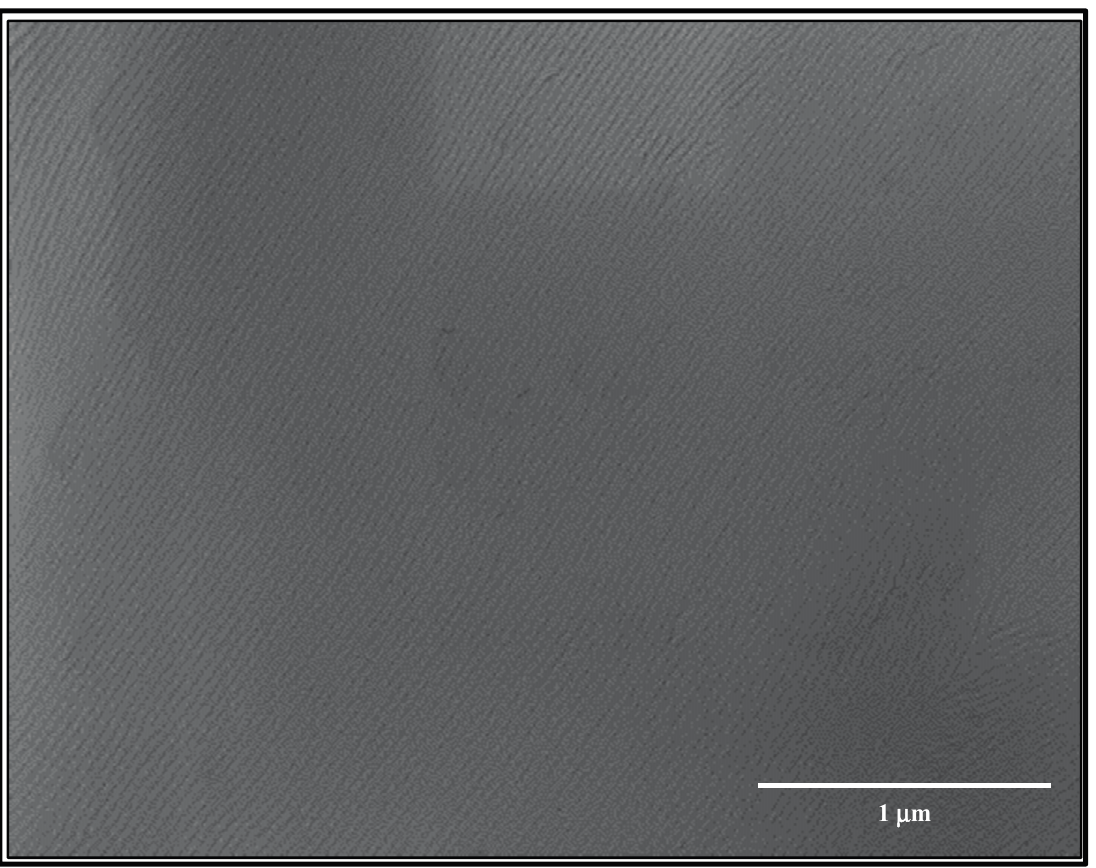
Figure A1. Top-down SEM image (lower magnification) of the PS- b -PDMS structure at a planar Si 3 N 4 substrate following microwave treatment at 50 °C for 30 s in toluene (light grey lines are oxidized PDMS and darker lines are voids created following partial PS